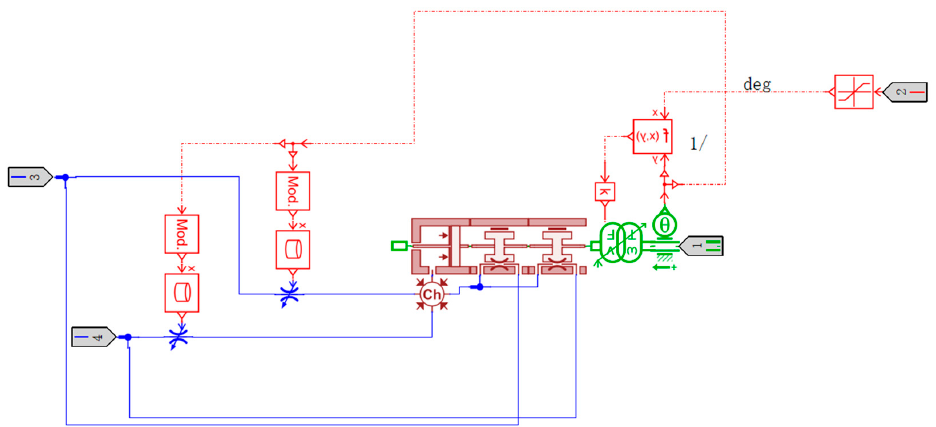
Figure 6. Axial piston pump.